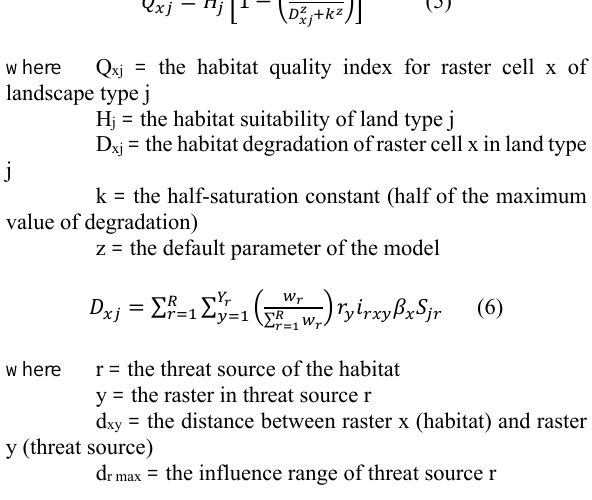
Figure 1 . IIC and PC changes in Beijing from 2000 to